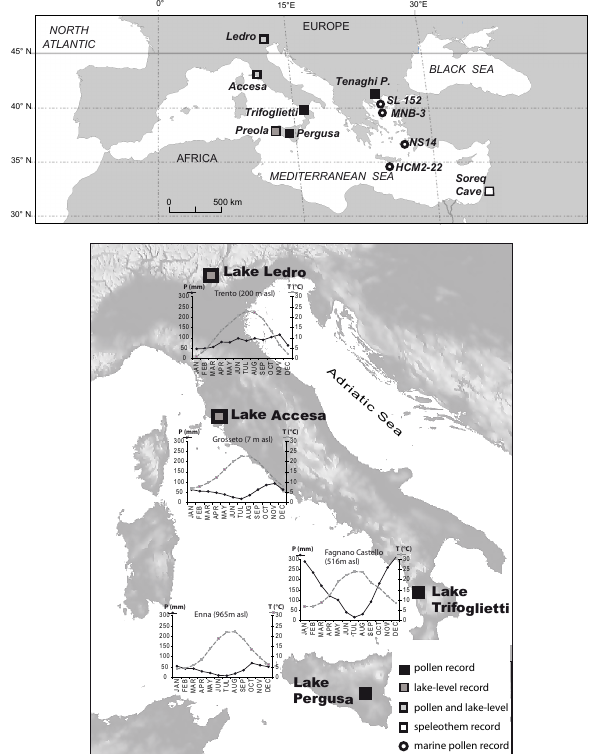
recordpollen Fig. 1. Geographic location of the study sites along a latitudi- nal gradient from northern Italy to southern Italy: Lakes Ledro in northern Italy (45 ◦ 87 0 N, 10 ◦ 76 0 E, 652m), Accesa (42 ◦ 59 0 N, 10 ◦ 53 0 E, 157m) in north-central Italy, Trifoglietti in southern Italy (39 ◦ 33 0 N, 16 ◦ 01 0 E; 1048m), and Pergusa (37 ◦ 31 0 N; 14 ◦ 18 0 E, 667m) in central Sicily. Other sites mentioned in the text and om- brothermic diagrams are also